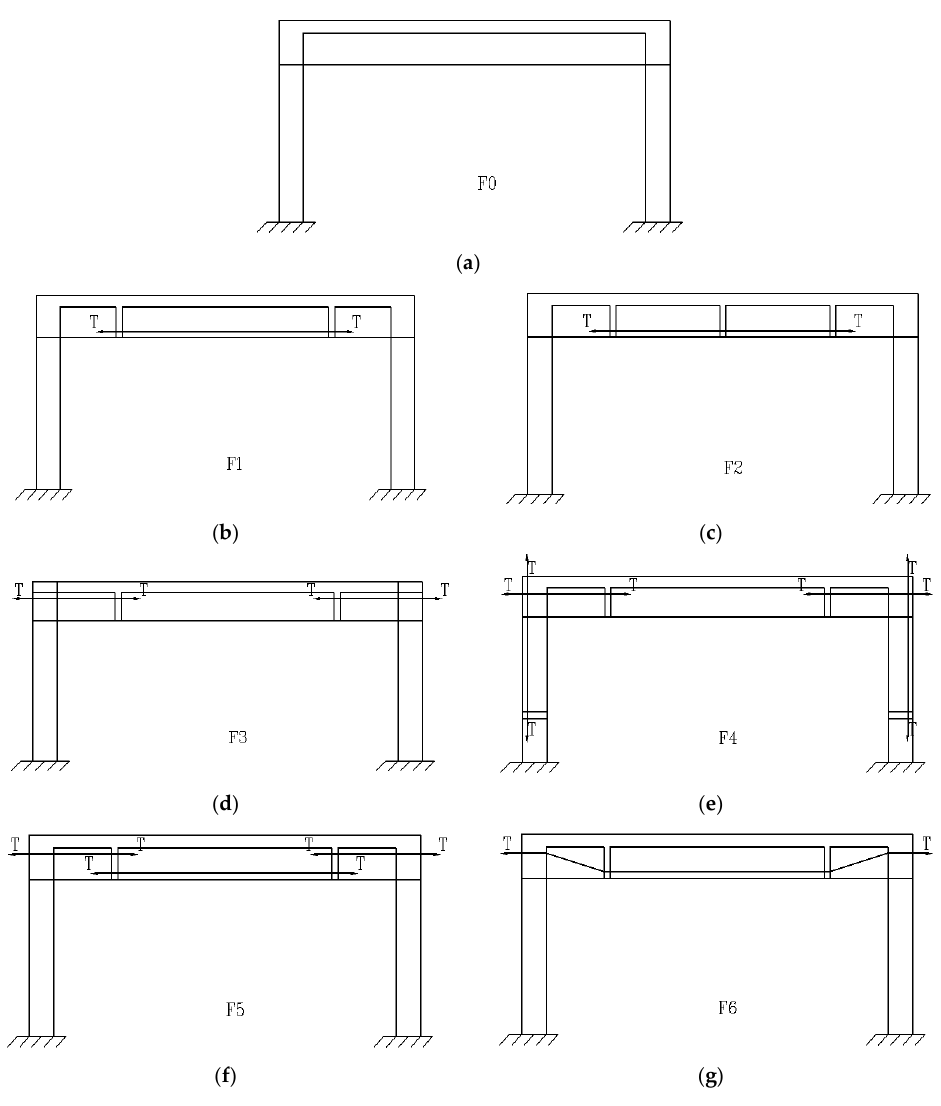
Figure 1. Different methods of external pre-stressing strengthening: ( a ) Unstrengthened (original) frame; ( b ) tendons in the positive bending zone; ( c ) tendons in the positive bending zone with mid-deviator; ( d ) tendons in the negative bending zones of the beam; ( e ) tendons in the negative bending zones of the frame; ( f ) tendons in positive and negative bending zones; ( g ) U-shaped tendons along the